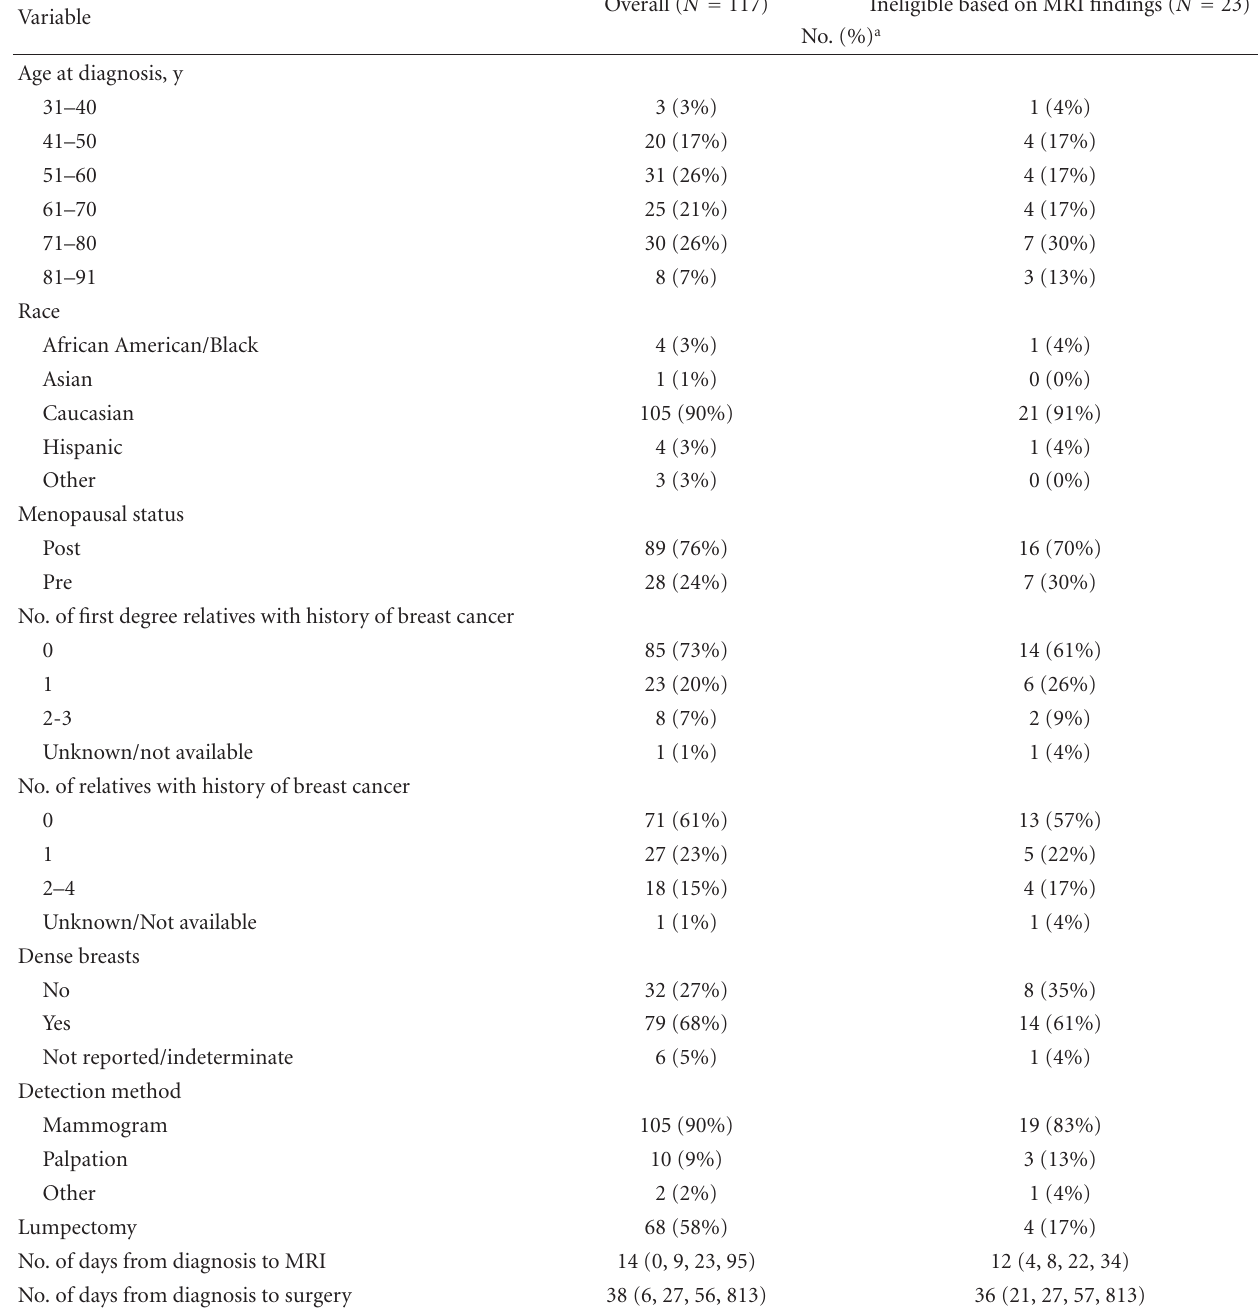
Table 1: Characteristics of 117 women with DCIS eligible for partial breast irradiation on the basis of an initial clinical evaluation, and of the 23 women ultimately ineligible by